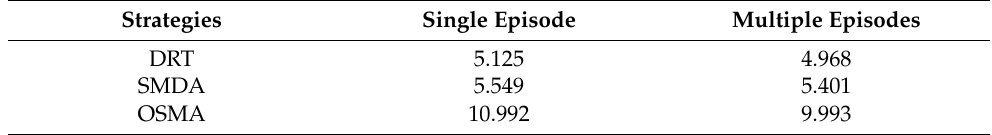
Table 5. Average task execution delay compared with SMDA and OMSA ( × 10 − 3 ms).